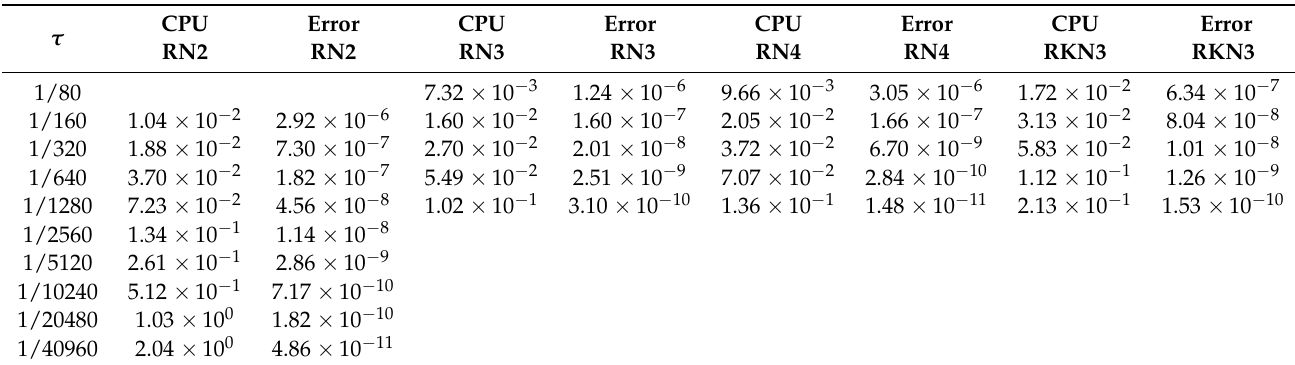
Table 10. Computational cost for problem (3) with RNRN2, RN3, RN4, and RKN3